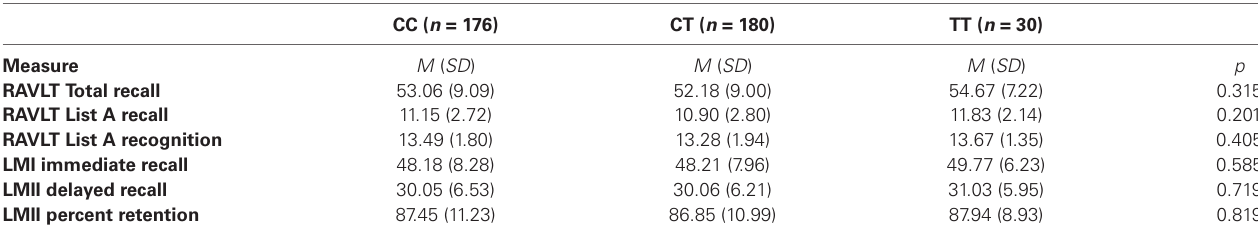
Table 2 | Verbal episodic memory performance across KIBRA